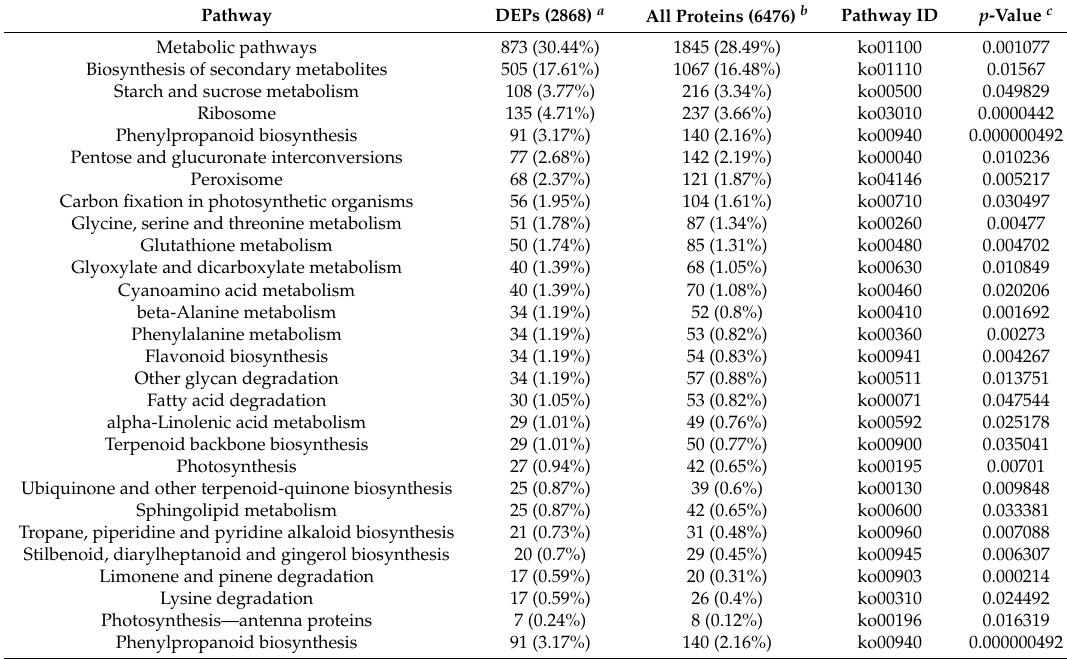
Table 1. Kyoto Encyclopedia of Genes and Genomes (KEGG) Pathway Enrichment Analysis of differentially expressed proteins (DEPs) ( p <